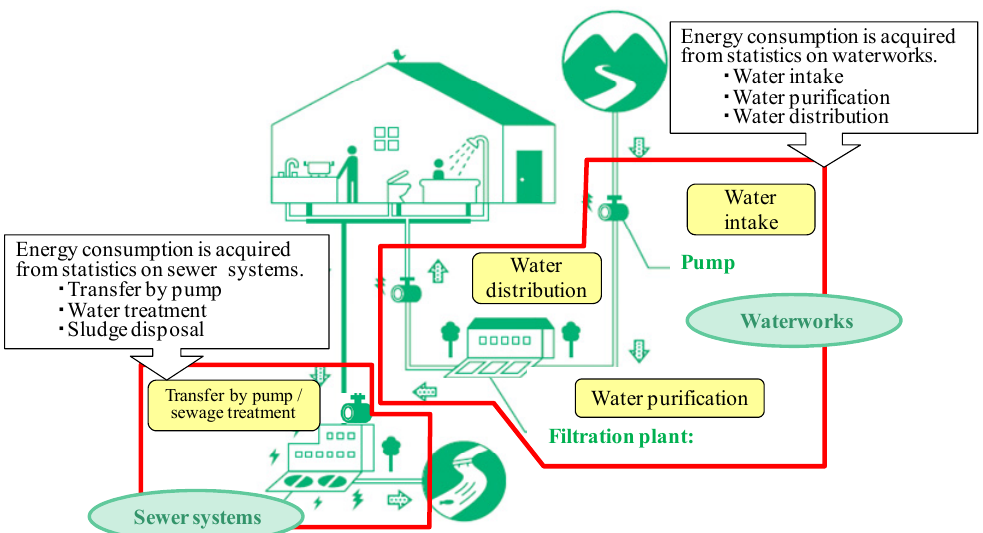
emission factor of 2